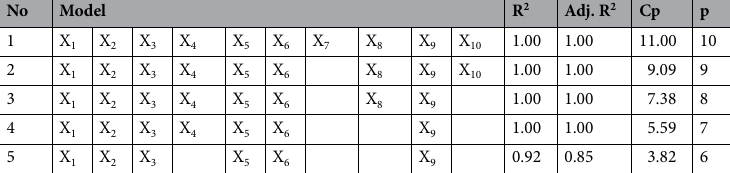
Table 8. Coefficients of determination (R 2 ), Adjusted (Adj) R 2 , Cp and number of parameters (p) for the best models to predict body weight in Bohor Reedbuck. Body length [x 1 ], head length [x 2 ], neck length [x 3 ], ear length [x